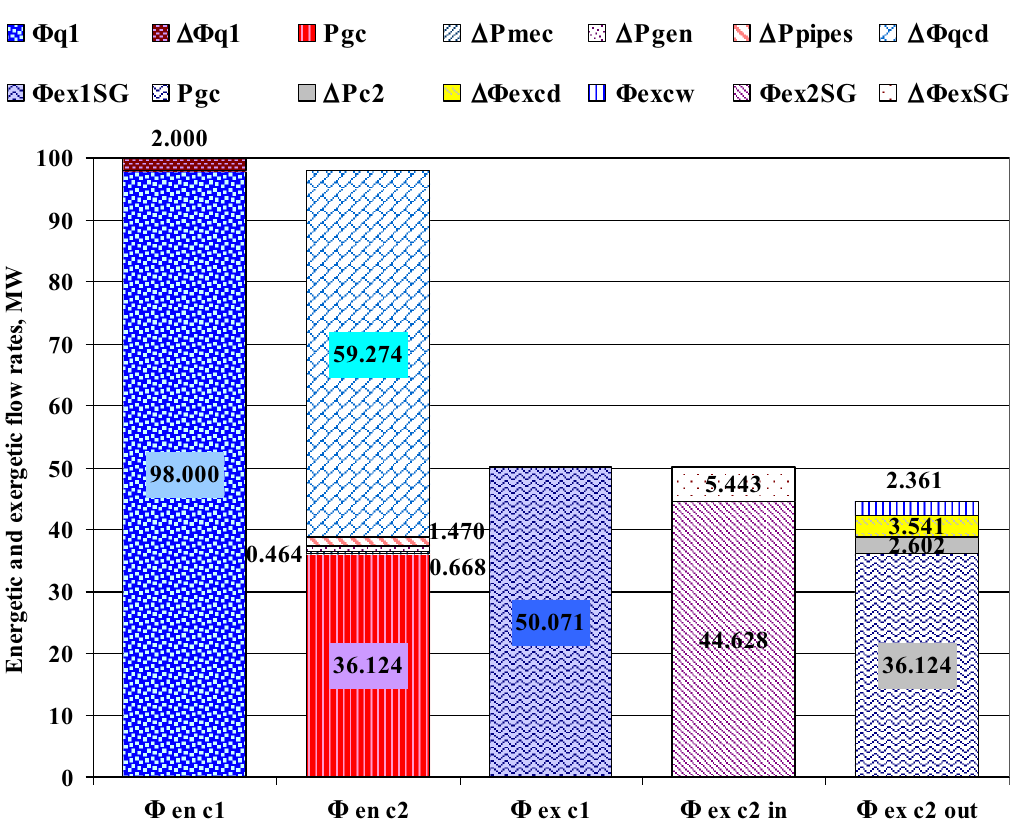
Fig. 6. The energetic and exergetic fl ows rates diagram for the analyzed